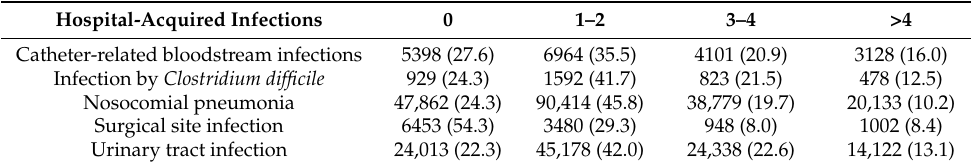
Table 4. Overall frequencies of HAI contexts between 2014 and 2017 by CCI